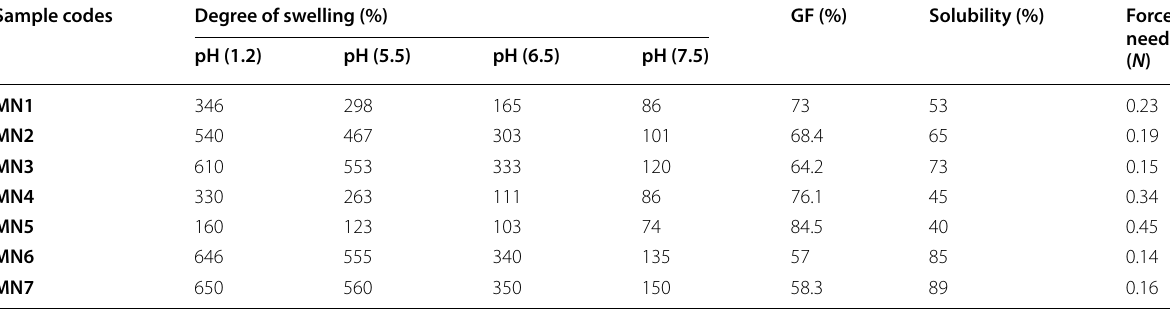
Table 2 The results of swelling, GF, solubility, and mechanical strength tests Sample